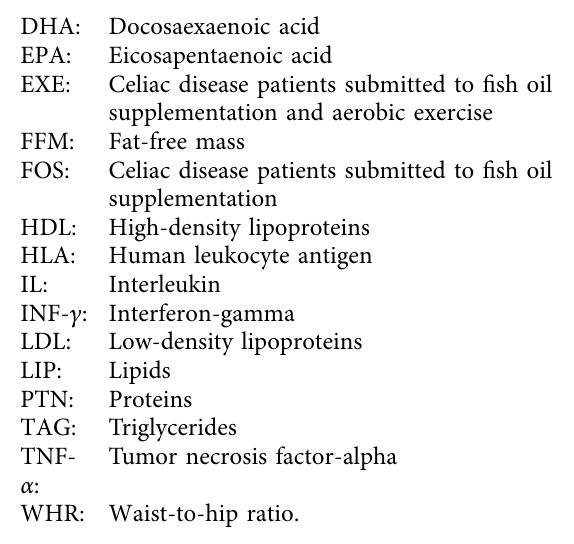
P P 12. 0 . 05; 0 . 01. CRP—C-reactive protein expressed in milligrams (cid:31) ∗ ∗∗ < <